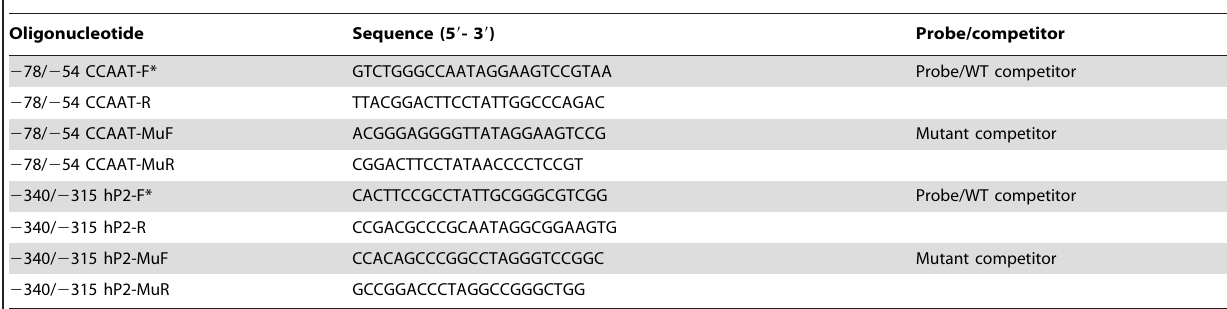
Table 3. Oligonucleotides used in